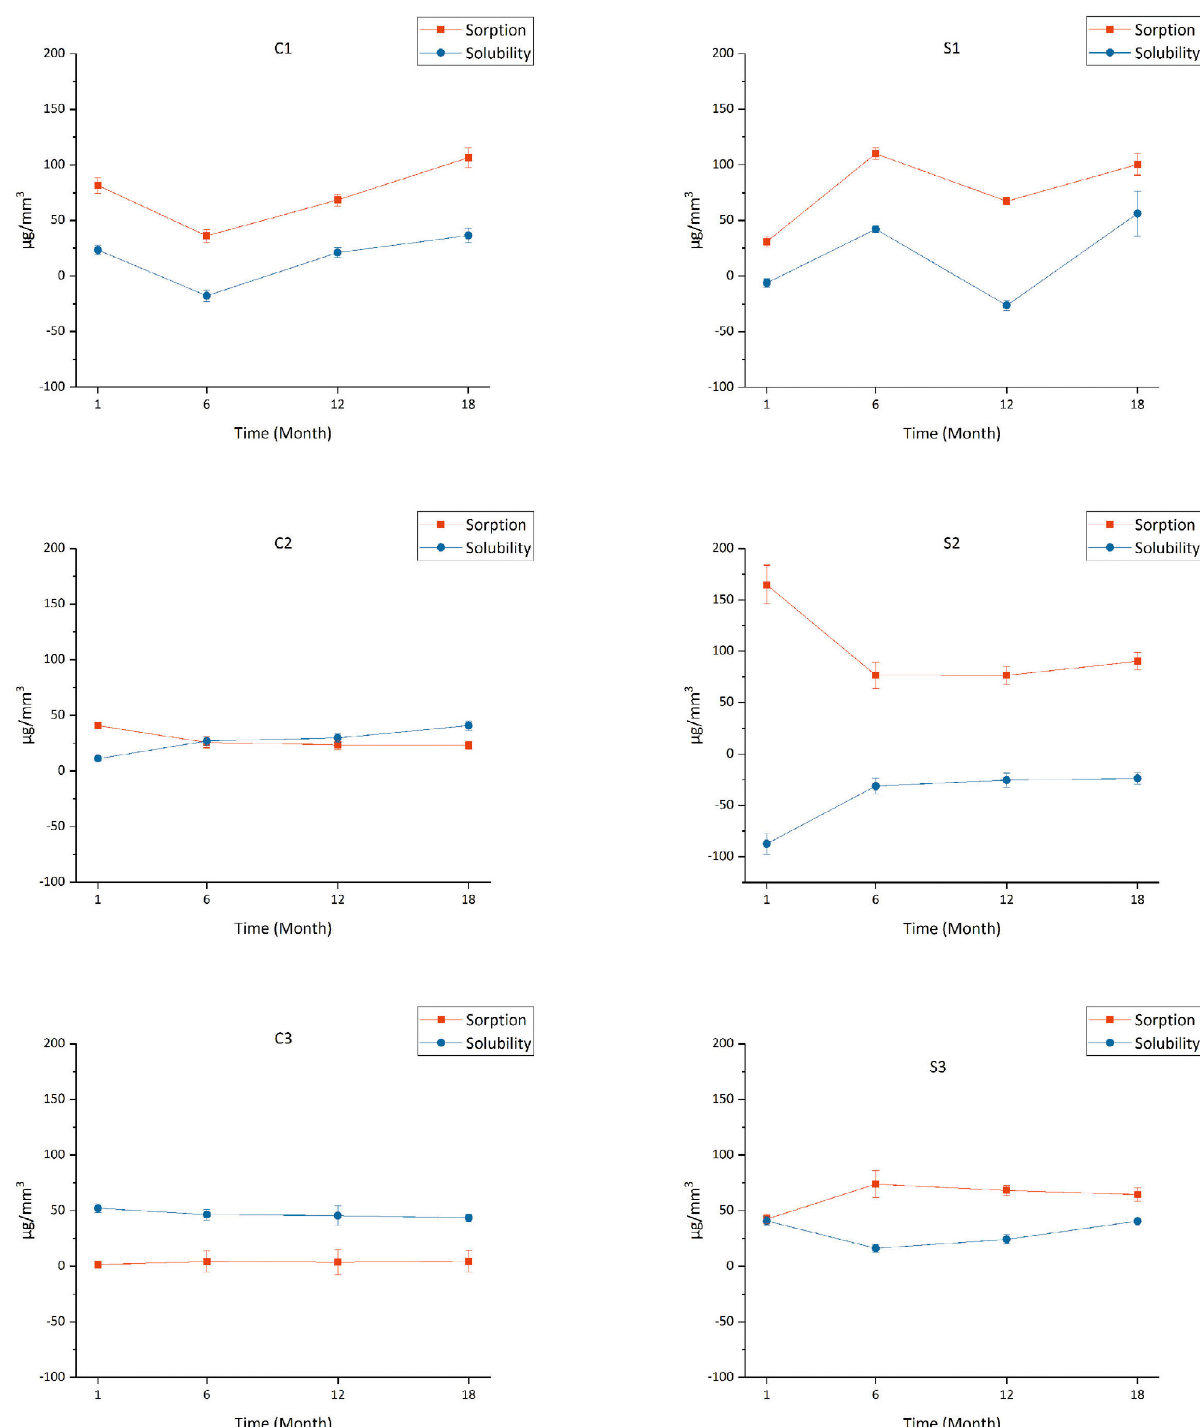
Figure 2- Sorption and solubility of conventional and self-adhesive resin cements during the total period of water